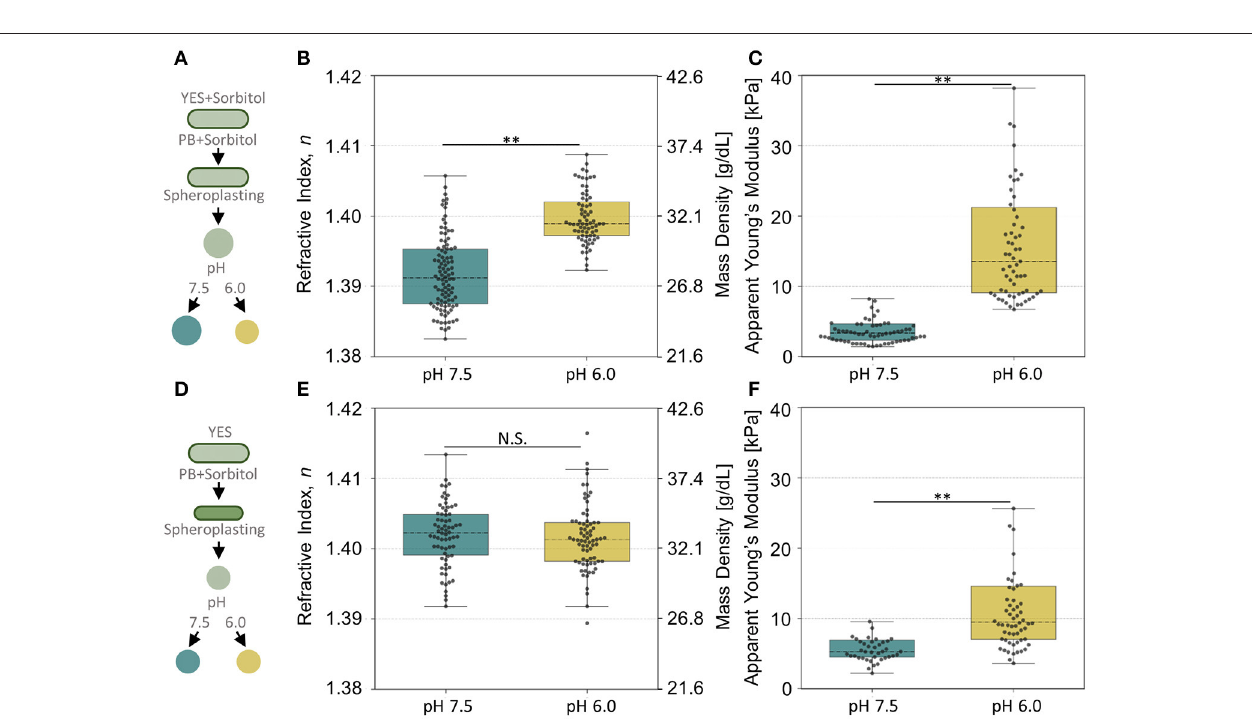
FIGURE 7 | Stiffness and mass density of yeast cells with different intracellular pH during or after adaptation to osmotic stress. (A,D) Schematic diagram for cell culture, spheroplasting in phosphate buffer (PB) with sorbitol and pH adjustment for (A) overnight osmotically adapted and (D) osmotically stressed S. pombe . (B,E) The distribution of mean refractive index of yeast cells with intracellular pH of 7.5 and 6.0 in (B) osmotic adaptation ( N > 70) and (E) osmotic stress ( N > 70). (C,F) The distribution of the apparent Young’s modulus of spheroplasts in the intracellular pH of 7.5 and 6.0 in (C) osmotic adaptation ( N > 60) and (F) osmotic stress ( N > 40). The box plot indicates the interquartile ranges (IQR) with a line at the median. The whiskers extend to the data within the 1.5 IQR of the respective quartile. Outliers outside of 1.5 IQR are not shown. ** p < 0.001.